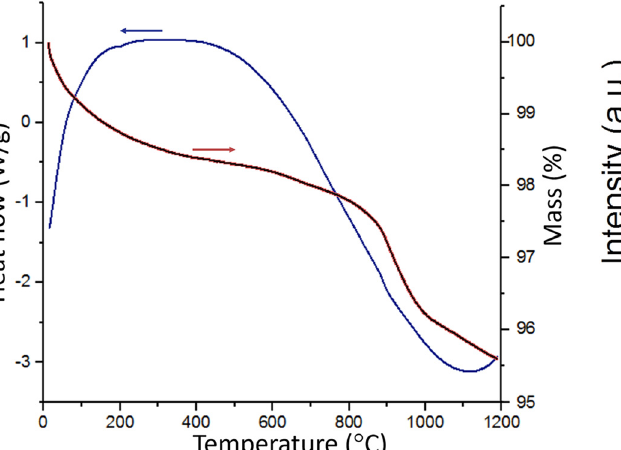
Figure 4: XRD patterns of the synthesized HA powder before and after calcination at 700 o C for 2